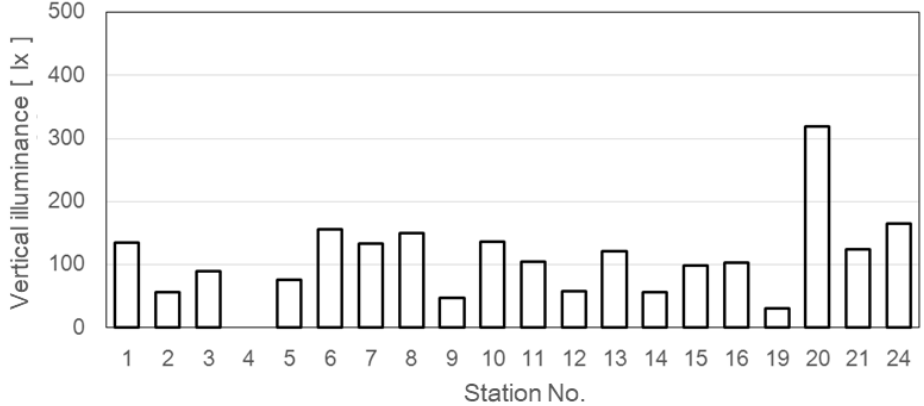
Figure 4. Vertical illuminance measurement result at the entrance of stairs.